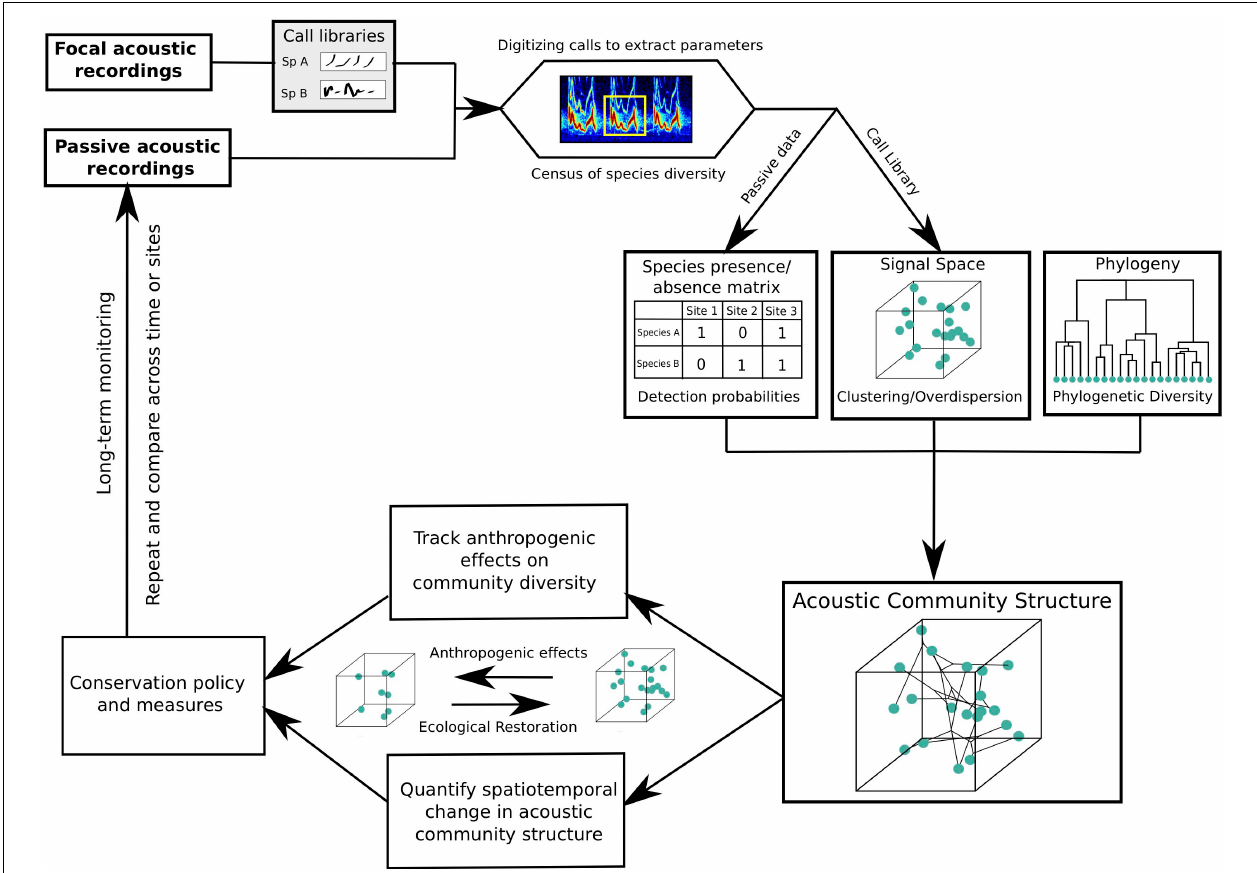
FIGURE 4 | A generalized work flow highlighting the utility of community bioacoustics in long-term monitoring and conservation. By combining a quantification of community signal space with phylogenetic analyses and passive acoustic census of spatiotemporal community diversity, we may track ecological changes, inform conservation measures and also gauge their success over